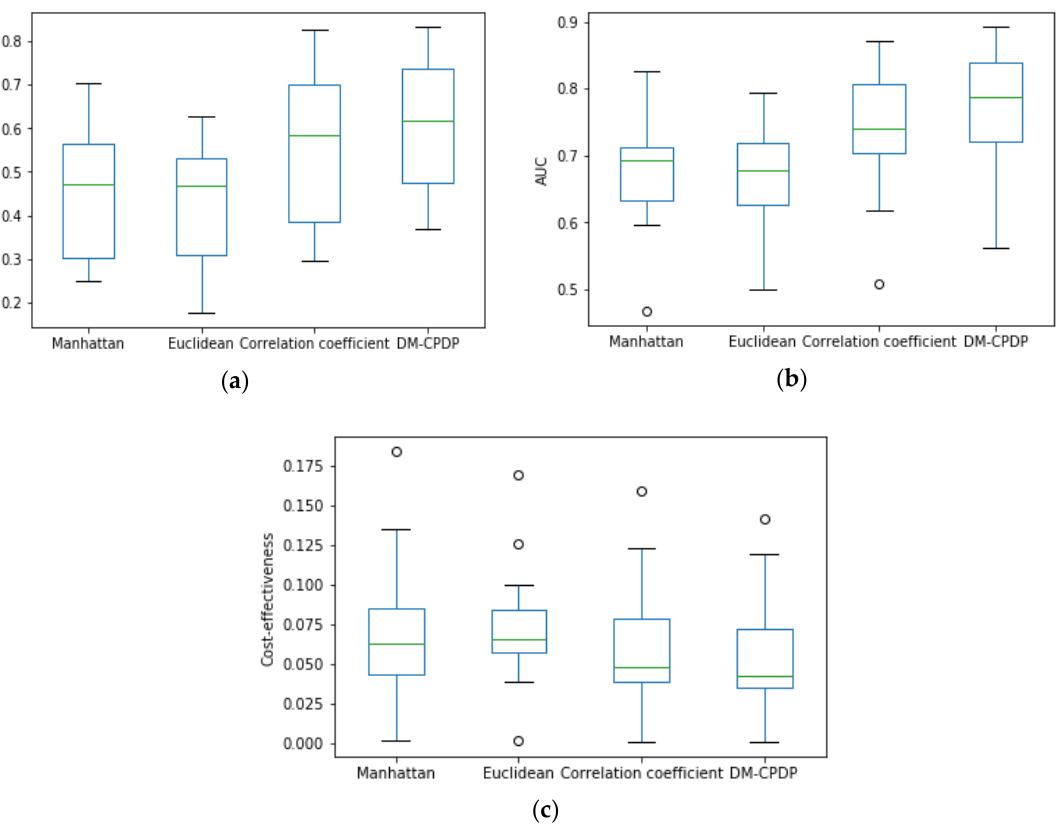
Figure 4. Box plot of different dissimilarity metric methods. ( a ) is the situation of each method on F-measure; ( b ) is the situation of each method on AUC; ( c ) is the situation of each method on cost-effectiveness. Box plots represent maximum, upper quartile, median, lower quartile and minimum values from top to bottom. In addition, circles represent outliers.